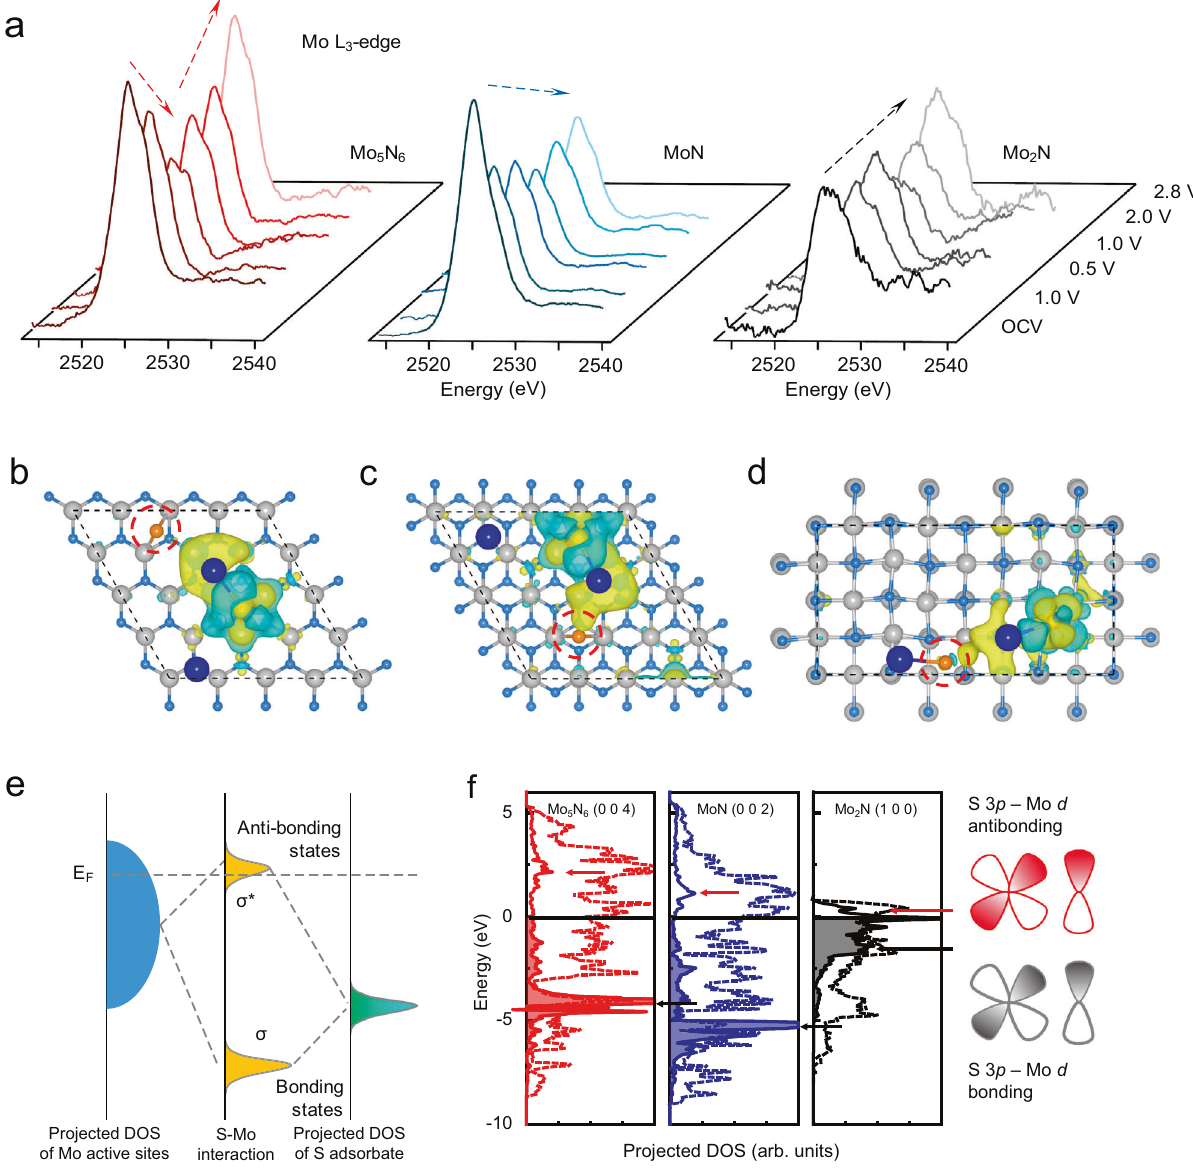
Fig. 6 Analyzes of Mo electronic structure in corresponding reaction transition state. a – c Ex-situ NEXAFS for the Mo L 3 -edge of S/Mo 5 N 6 , S/MoN, and S/Mo 2 N, for varying voltage during a discharge/charge cycle. b – d Charge difference analyzes from con fi gurations of the transition states in the NaS (cid:1) formation step on the three cathode materials, in which yellow-color and cyan iso-surface represent electron accumulation and electron depletion, respectively, and the iso-surface value is 0.0015 e Å − 3 . Color code is the same as for Fig. 5c. e Energy level diagram showing orbital hybridization for adsorption sites and adsorbate. E F is the Fermi level of the substrate; σ and σ * indicate bonding and anti-bonding states, respectively. f Solid lines represent DOS for S in the red-color circles in Fig. 6b – d. The DOS is projected onto the S 3 p state. Dashed lines represent surface Mo d -bands DOS of the three clean molybdenum nitrides